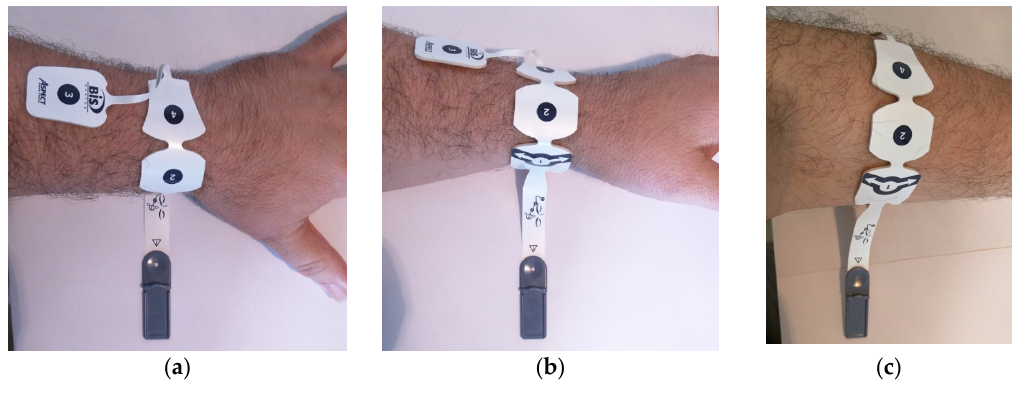
Figure 2. Positioning of the BIS ‐ Quatro TM sensor system band around the wrist ( a ) and ( b ), and around the forearm ( c ) on the left ‐ arm.